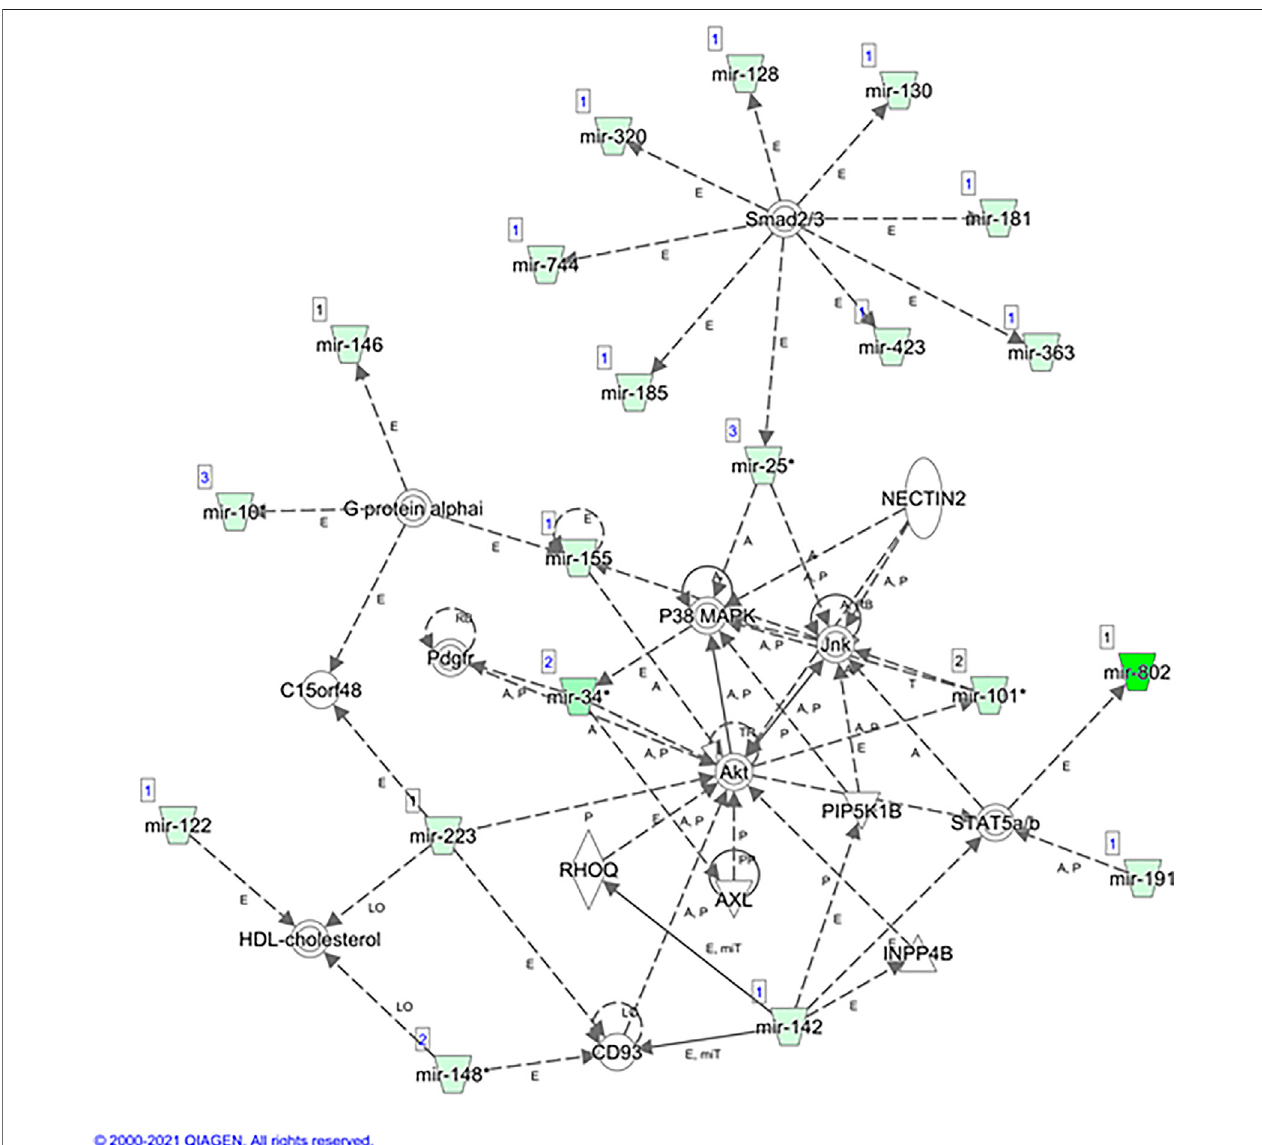
FIGURE 4 | Predicted network. Interaction network of miRNAs and genes related to connective tissue disorders, gene expression, and in fl ammatory diseases, obtained with the IPA bioinformatic analysis for the 99 miRNAs signi fi cantly upregulated in the BTBR ob/ob mice group.